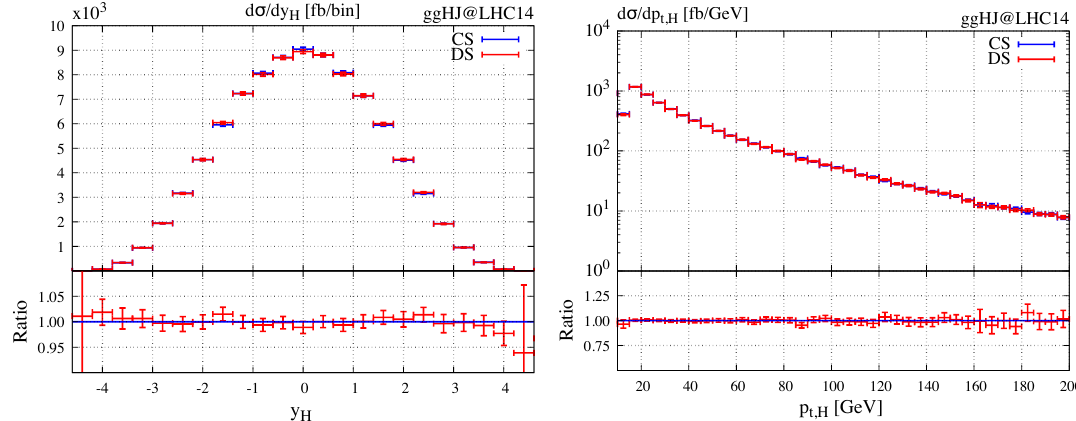
Figure 11. Higgs boson rapidity (left) and transverse momentum (right) distributions for H plus 1 jet production in proton-proton collisions at 14 TeV center-of-mass energy ( gg -channel only). The Dual Subtraction (DS) results are shown in red, while the Catani-Seymour (CS) ones in blue. The error bars correspond to the statistical error given by the Monte Carlo